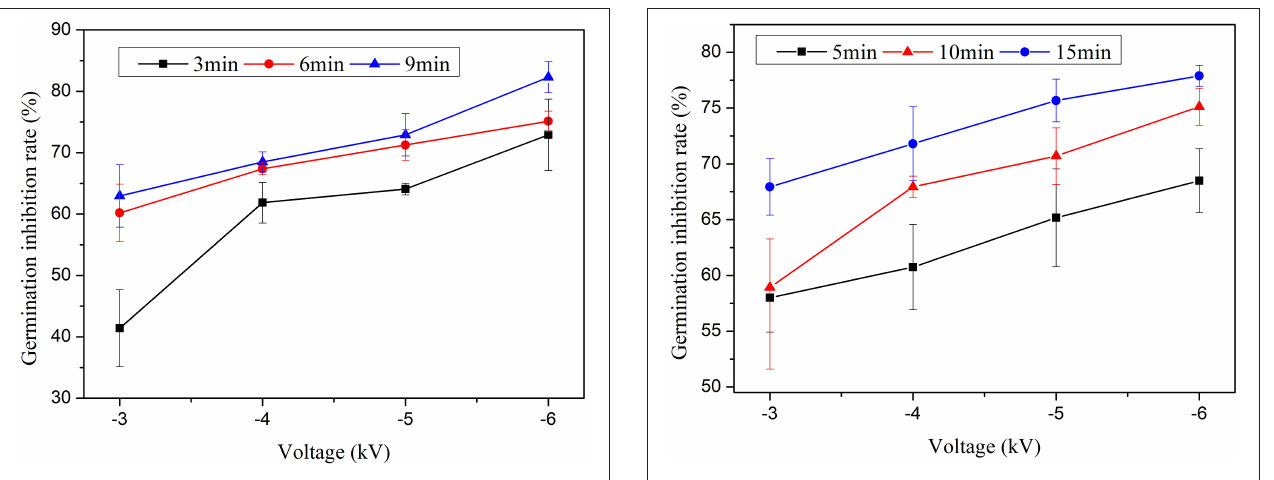
FIGURE 3 | Changes in the inhibition efficiency with the treatment time at various voltages when the water content is 9.57mg L − 1 , the response time is 10min, and the storage time is 5min.